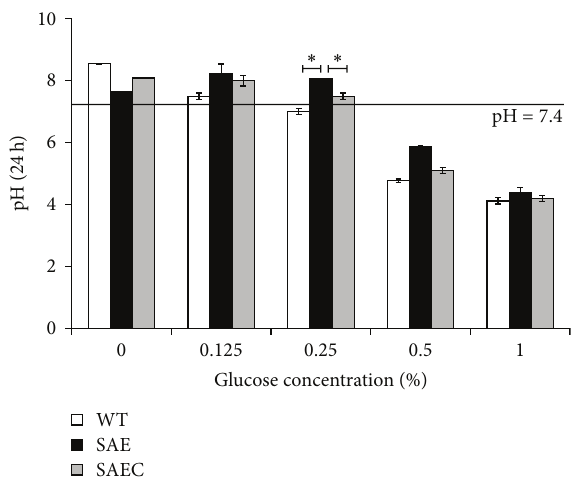
Figure 6: pH value of S. epidermidis 1457 in BM medium containing various concentrations of glucose. SAE, WT and SAEC were grown withorwithout0.125%,0.25%,0.5%,and1%(g/mL)glucosefor24 h. Then, the cultures were centrifuged. The pH of the supernatant was determined by using a pH meter (FE20, Mettler-Toledo, Shanghai, China).